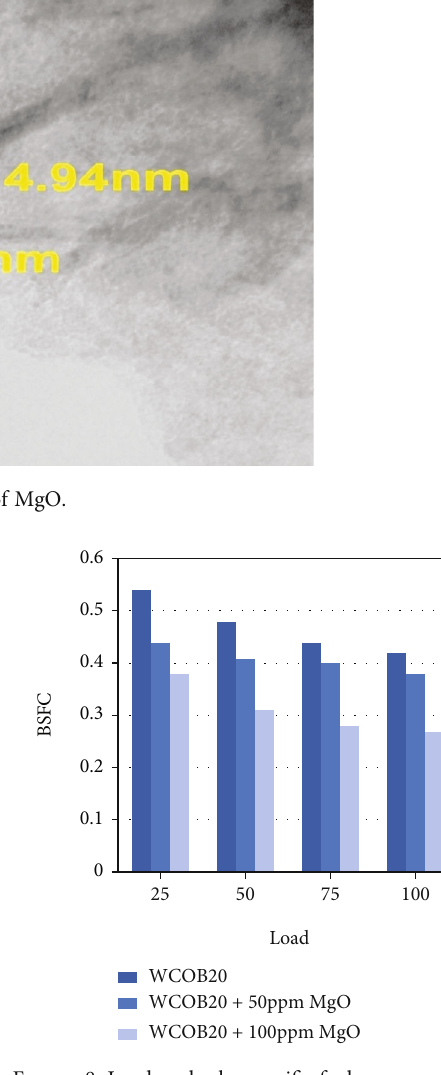
Figure 8: Load vs. brake-speci fi c fuel consumption.